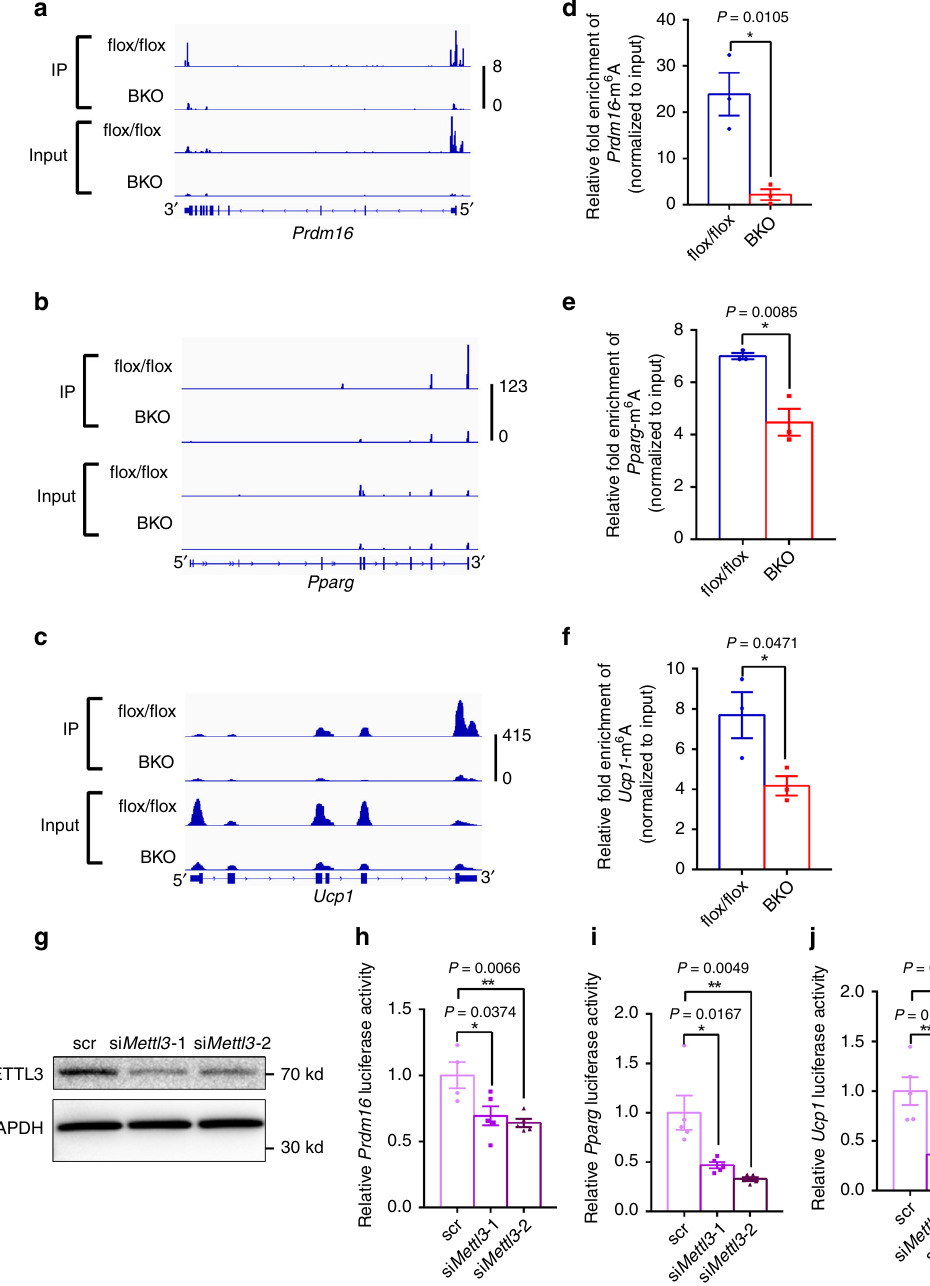
Fig. 5 METTL3 is essential for m 6 A modi fi cation of Prdm16 , Pparg, and Ucp1 transcripts. a – c The read density from m 6 A-RIP-seq experiments on BKO – fl ox/ fl ox pairs showing the m 6 A peaks identi fi ed in the Prdm16 , Pparg, and Ucp1 transcripts. d – f The m 6 A modi fi cation in Prdm16 , Pparg, and Ucp1 transcripts in iBAT of 8-week-old Mettl3 fl ox/ fl ox and BKO mice were measured by m 6 ARIP-RT-qPCR ( n = 3 for each group). g – j Primary brown preadipocytes seeded in 24-well plates were co-transfected with pMIR-REPORT Luciferase vectors ( Prdm16 , Pparg , Ucp1 ), siRNAs (Scramble siRNA, si Mettl3 -1, si Mettl3 -2) and β -galactosidase ( β -Gal) reporter plasmid by X-tremeGENE siRNA Transfection Reagent for 24h. Cells were then induced to differentiate for 48h. METTL3 and GAPDH protein levels were measured by immunoblotting g . Relative Prdm16 , Pparg, and Ucp1 luciferase activity were measured and normalized to β -Gal levels h – j (Scr in h , n = 4; others, n = 5 biologically independent cell samples for each group). Data represent the mean± SEM. Signi fi cance was determined by unpaired two-tailed Student ’ s t test analysis. * p < 0.05. ** p <0.01. Source data are provided as a Source Data fi